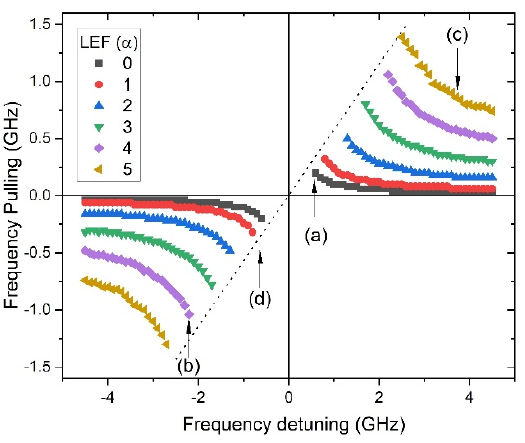
Figure 2. Frequency pulling vs. frequency detuning for different values of the LEF (0 − 5) at a constant injection level ( − 30 dB). The dashed line represents the locking bandwidth. The labels ( a – d ) represent the points at which the power spectra in Figure 3 are taken.